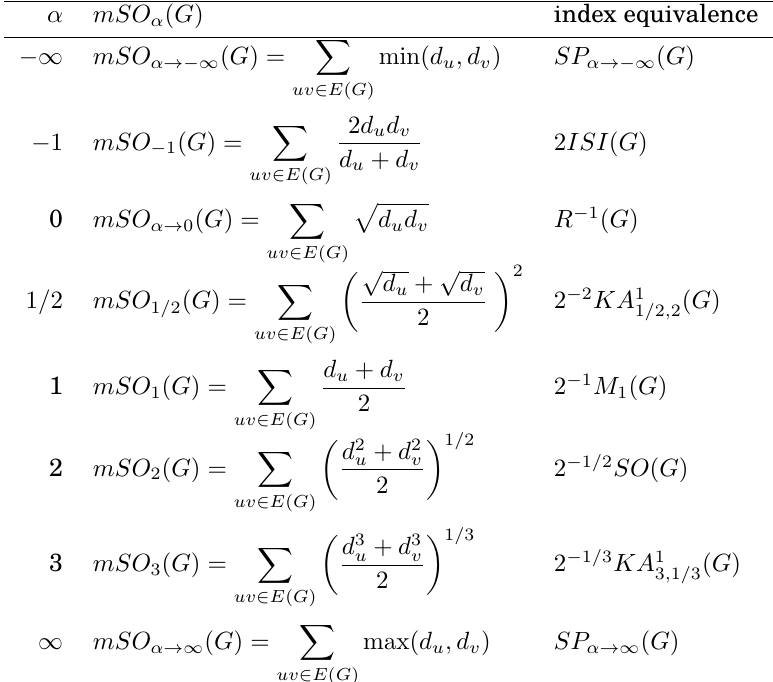
Table 2: Expressions for the mean Sombor index mSO